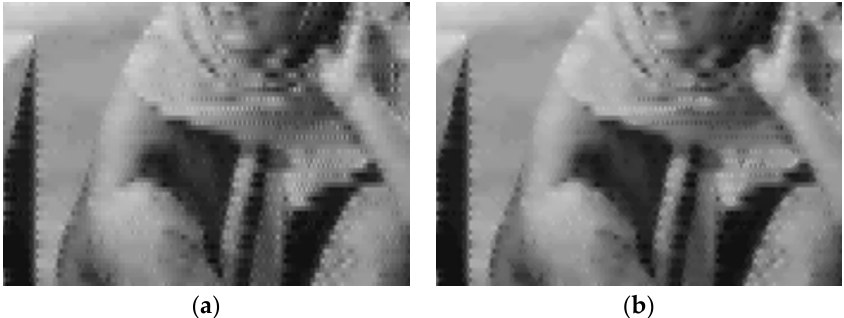
Figure 14. Enlarged recovery details of a large area attack on the Barbara image: ( a ) the method of [7]; ( b ) the proposed method.